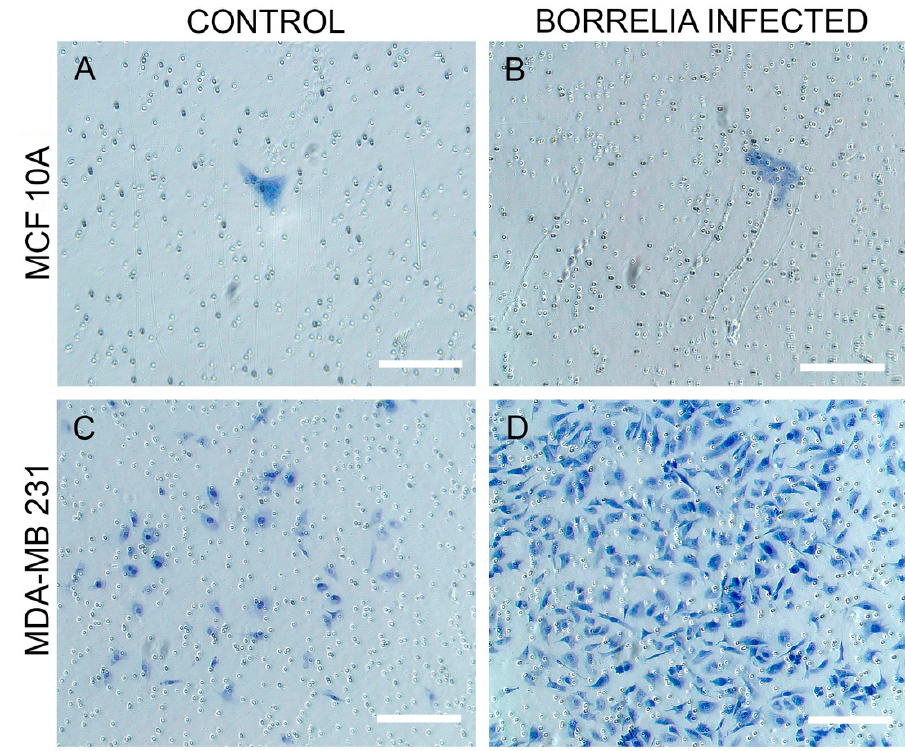
Figure 5. Matrigel-based invasion assay of ( A ) MCF 10A uninfected cells versus ( B ) MCF 10A after infection with B. burgdorferi , and ( C ) MDA-MB-231 uninfected cells versus ( D ) MDA-MB-231 after infection with B. burgdorferi after 72 h using 2 mg/mL concentration of Matrigel as described in Material and Methods. Scale bar: 200 µ m.